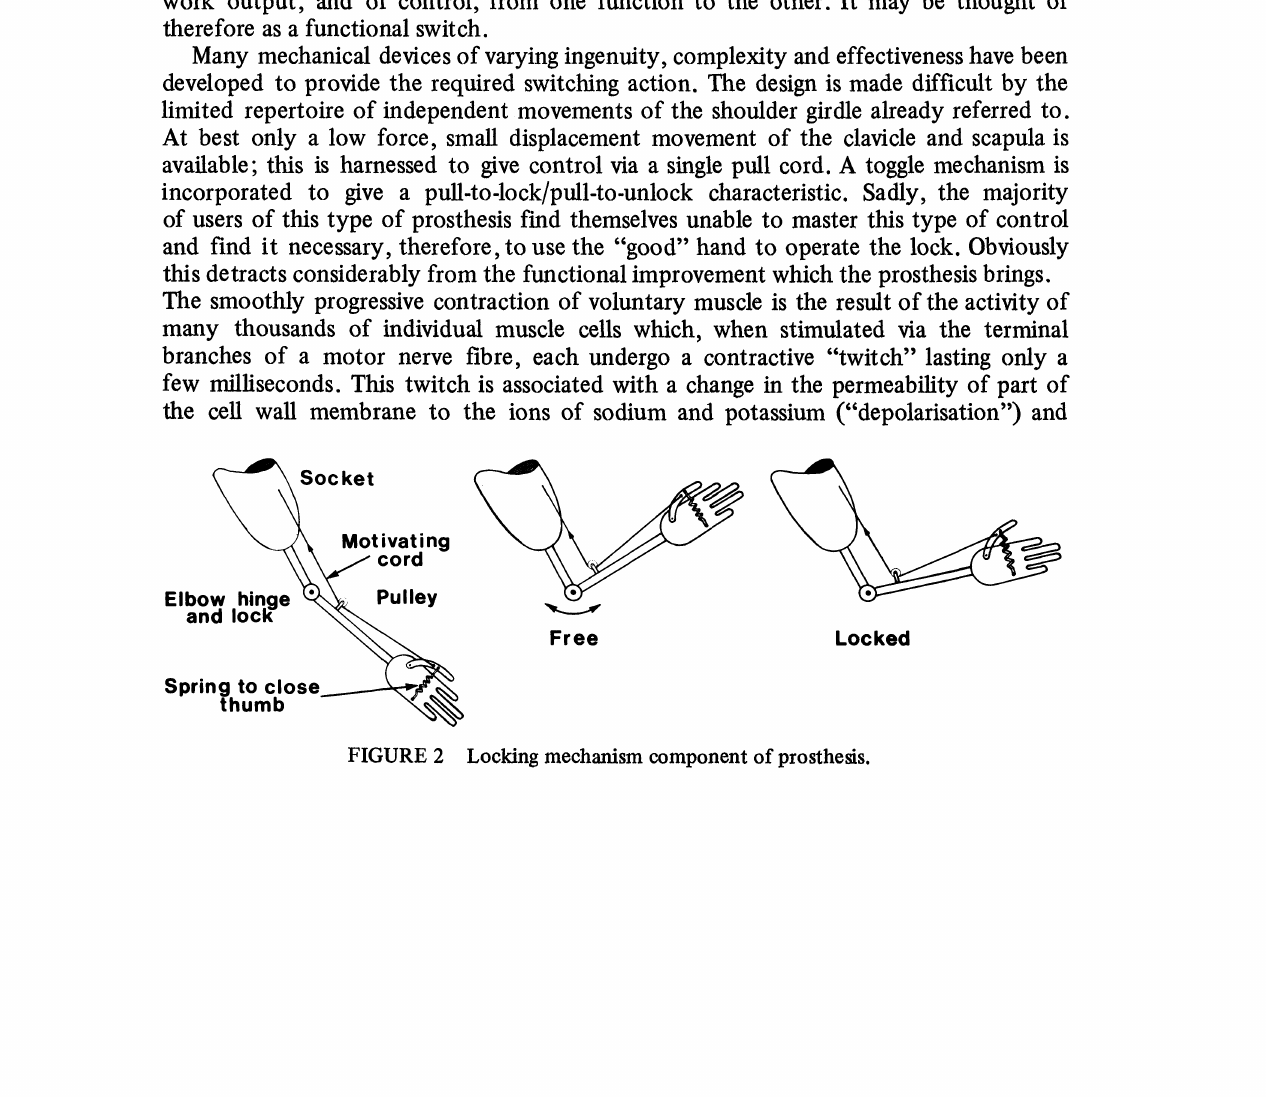
Motivating Cord